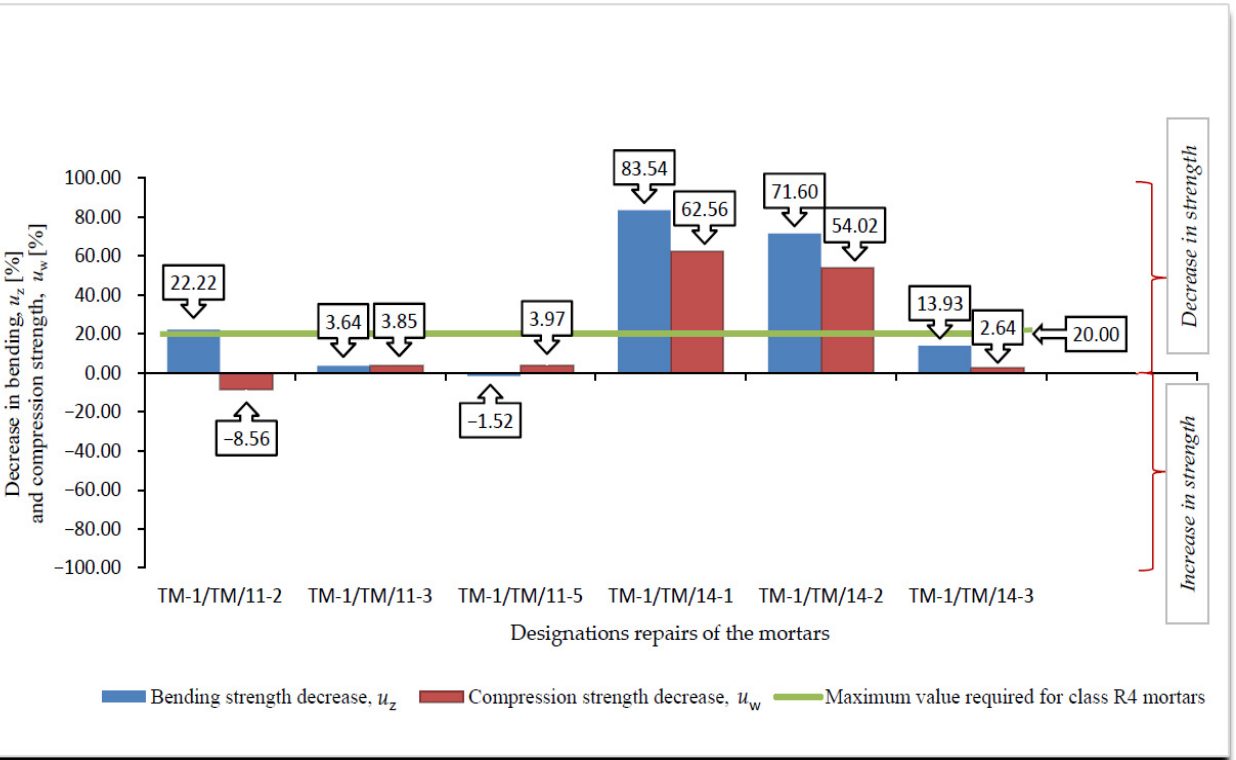
Figure 9. Summary of averages values of weight loss of R4 class mortars after frost resistance testing according to [4], u ms [%].